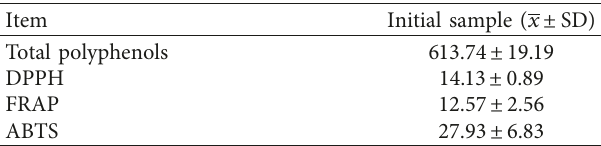
Figure 2: Changes in peroxide value (meq O 2 /kg) of the test oils stored with the addition of apple Table 5: The content of total polyphenols and antioxidant activity (DPPH, FRAP, and ABTS + ) of apple pomace ( µ mol Trolox/g).